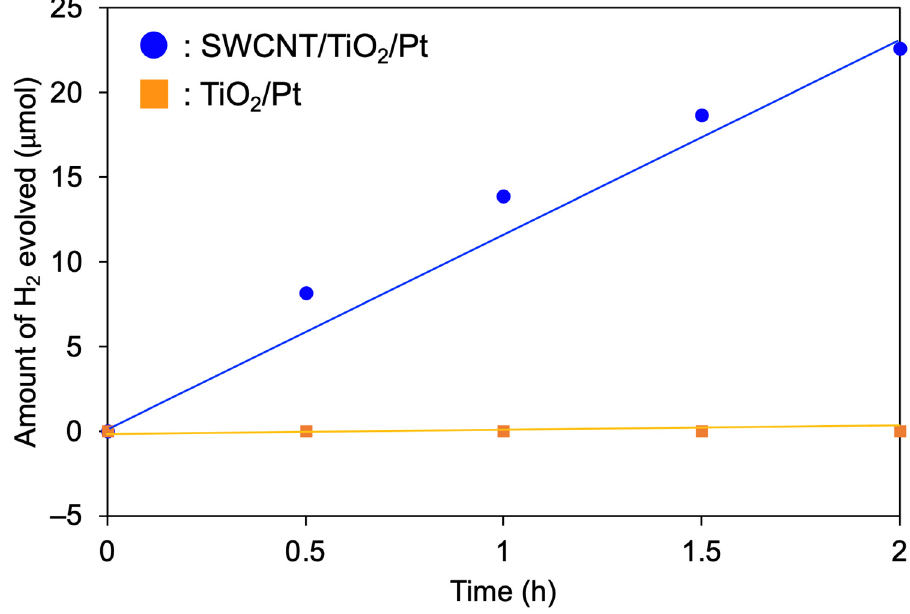
Figure 6. Time course of H 2 evolution from water over SWCNT/TiO 2 /Pt (blue line) and TiO 2 /Pt (orange line) under visible-light irradiation ( λ > 422 nm).